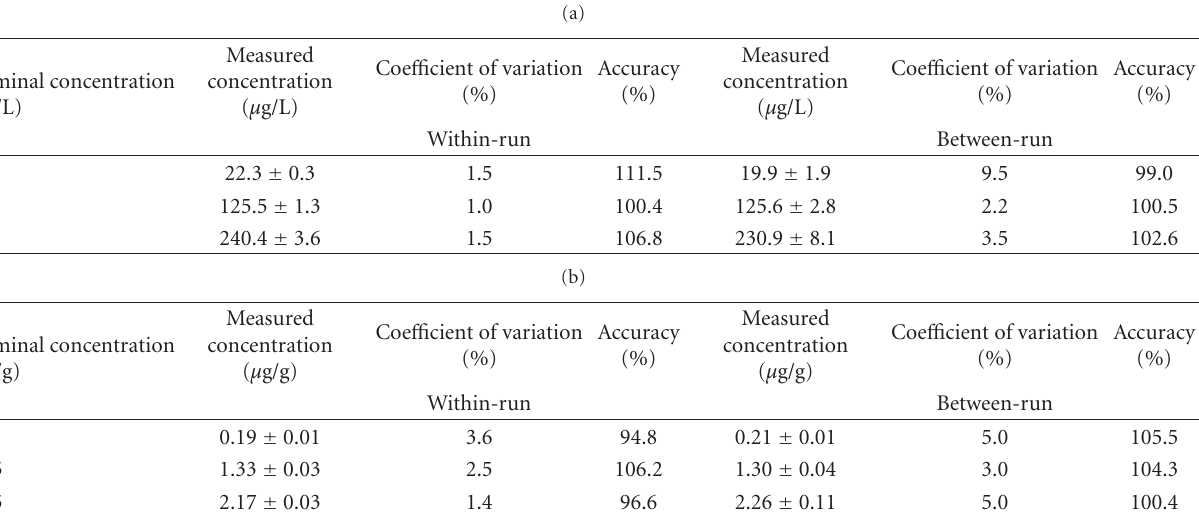
Table 1: Reproducibility of moxifloxacin plasma concentration (a) and brain tissue concentration (b) measurements: assay performance data ( n = 6).